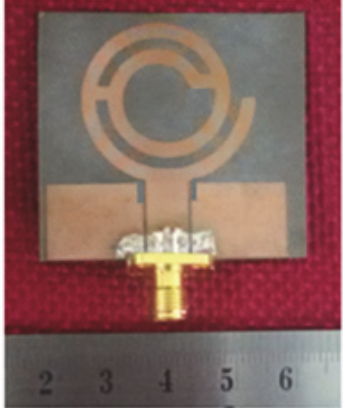
Figure 11: Prototype of antenna fabricated on Rogers RT/duroid 5880